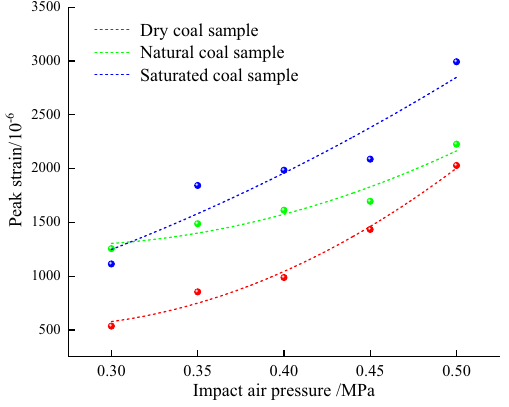
Figure 7. Peak strain versus loading pressure.